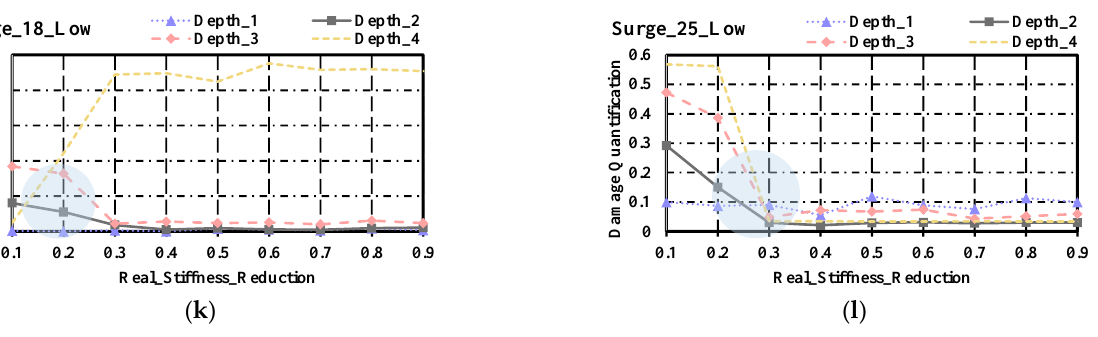
Figure 9. Comparison of different similarity functions. ( a ) Under 4 m/s, measured by C. ( b ) Under 11.4 m/s, measured by C. ( c ) Under 18 m/s, measured by C. ( d ) Under 25 m/s, measured by C. ( e ) Under 4 m/s, measured by E. ( f ) Under 11.4 m/s, measured by E. ( g ) Under 18 m/s, measured by E. ( h ) Under 25 m/s, measured by E. ( i ) Under 4 m/s, measured by SE. ( j ) Under 11.4 m/s, measured by SE. ( k ) Under 18 m/s, measured by SE. ( l ) Under 25 m/s, measured by SE.